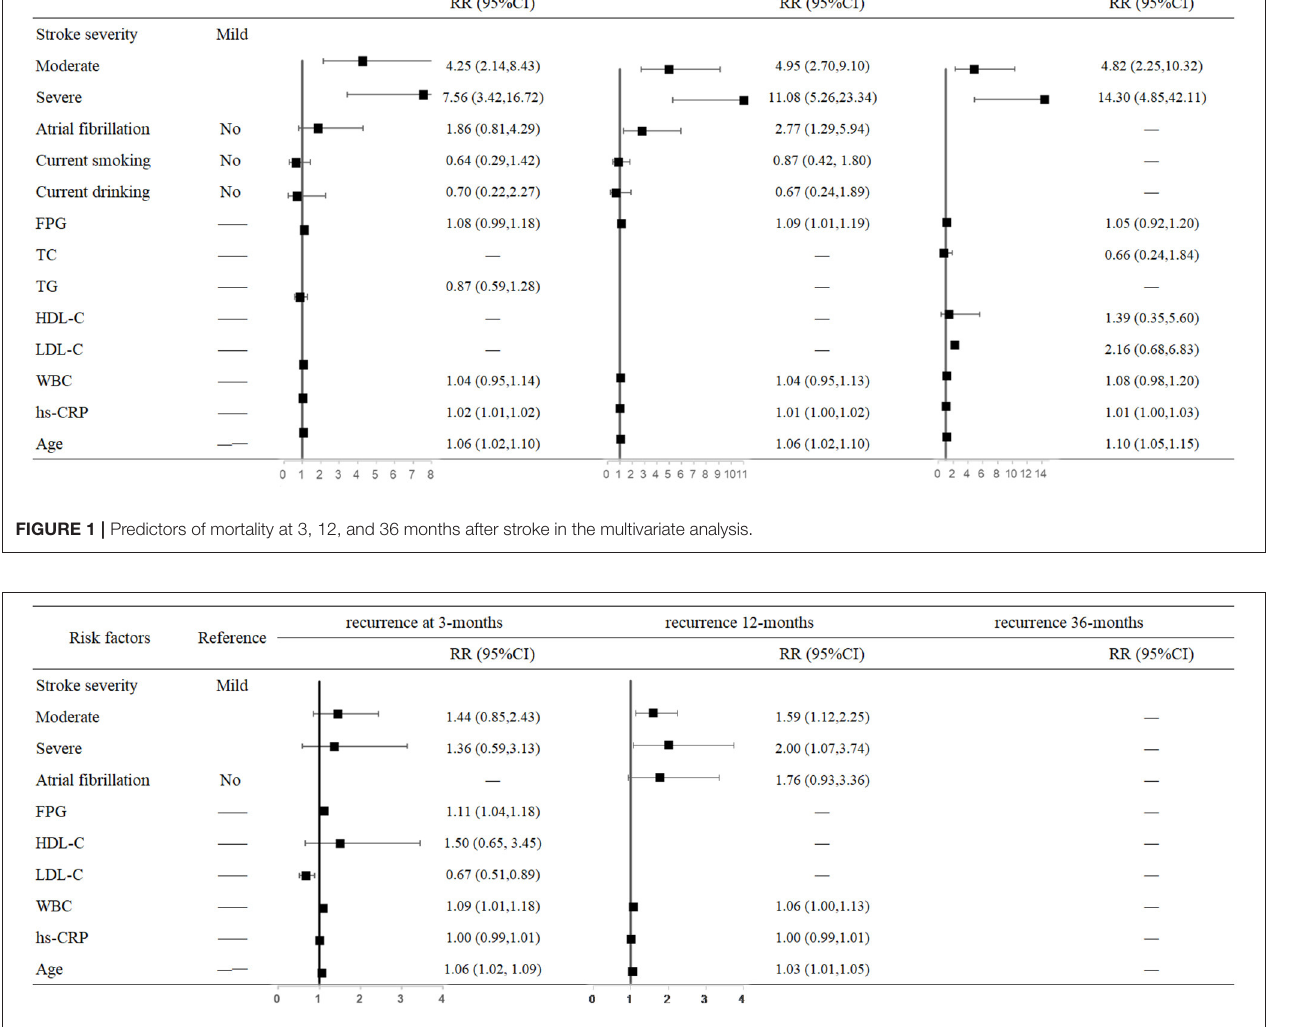
FIGURE 2 | Predictors of recurrence at 3, 12, and 36 months after stroke in the multivariate analysis.